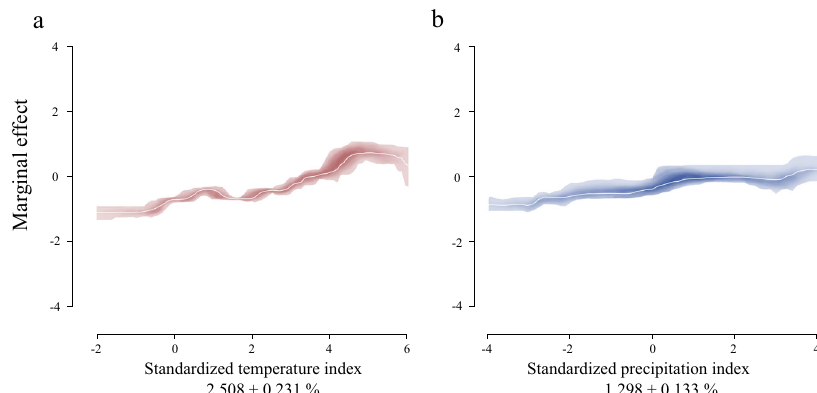
Fig. 2 Marginal effect curves of each climate deviation related covariate. The marginal effect curves of ( a ) standardized temperature index and ( b ) standardized precipitation index were generated by the boosted regression tree (BRT) ensemble fi tted to the full incidence samples under strategy a + . The white lines represent the mean effect curves calculated from the ensemble BRT models. 95% con fi dence intervals of climate variables are indicated by color: red, standardized temperature index; blue, standardized precipitation index. Sub-plots are ordered by the mean relative contribution (%) of covariates, with ± standard deviation (%) given within each sub-plot.